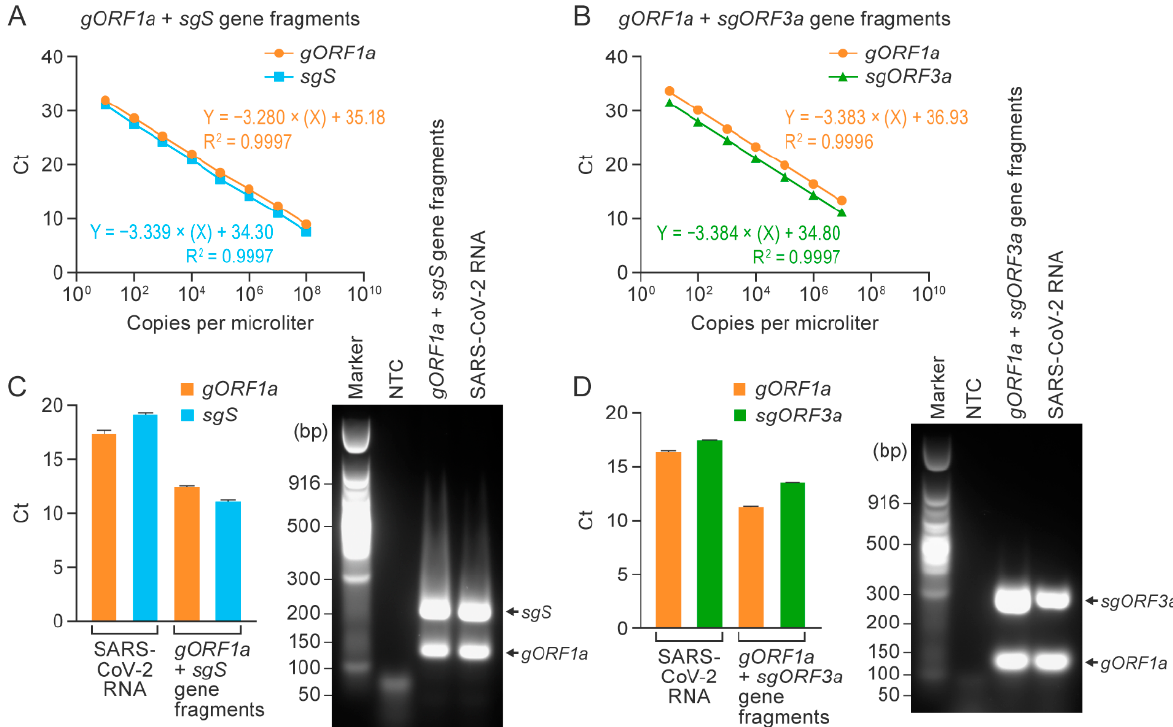
Figure 2. Duplex RT-qPCR assays specifically detect SARS-CoV-2 genomic and subgenomic nucleic acids. Duplex RT-qPCR assays were performed on serially diluted synthetic gene fragment mixtures using ( gORF1a + sgS ; ( A )) or ( gORF1a + sgORF3a ; ( B )). Experiments were performed thrice, with three replicates for each reaction. Mean Ct values for duplex assays for RNA from SARS-CoV-2-exposed Vero cells and positive controls ( gORF1a + sgS/gORF1a + sgORF3a) gene fragments ( C , D ). Error bars depict standards deviations. Gel images show amplification products after RT-qPCR in ( C , D ). RT-qPCR = real-time reverse transcription PCR; SARS-CoV-2 = severe acute respiratory syndrome coronavirus 2.